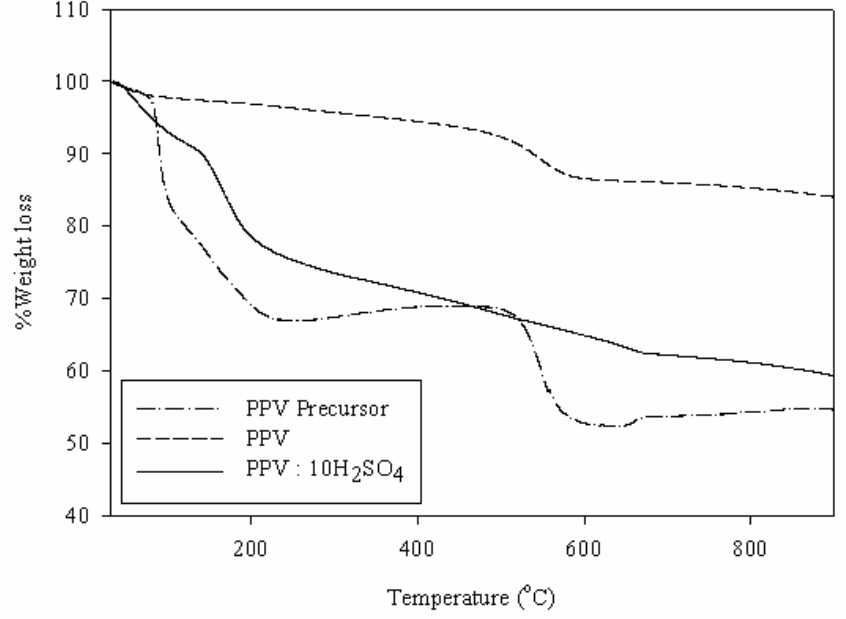
Figure 1. TGA thermogram of PPV Precursor, PPV and doped